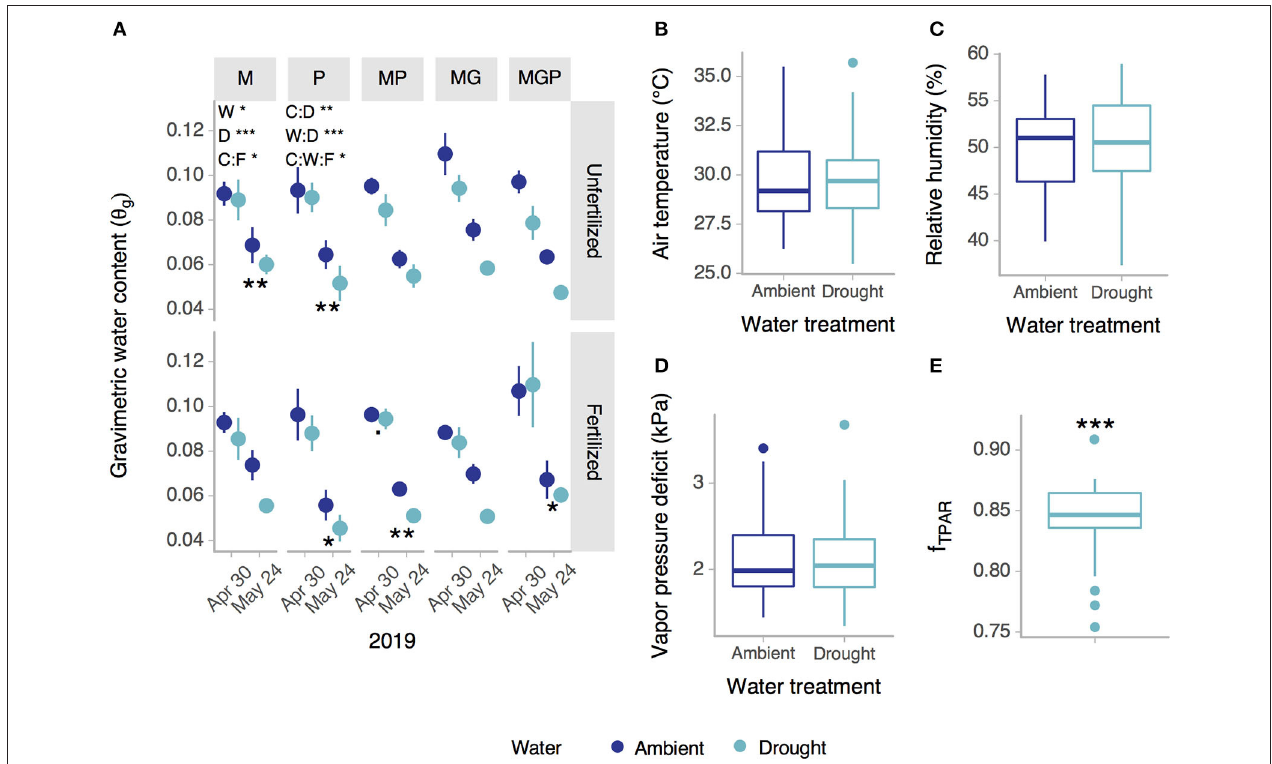
FIGURE 2 | Effects of rainout shelters on (A) gravimetric water content (0–20cm), (B) air temperature, (C) relative humidity, (D) vapor pressure deficit, and (E) the fraction of transmitted photosynthetically active radiation (f TPAR ), (A) within or (B–E) across cropping system-fertilization combinations. Cropping system abbreviations: M, Maize; P, Pigeonpea; MP, Maize-pigeonpea; MG, Maize-gliricidia; MGP, Maize-gliricidia-pigeonpea. Treatment factor abbreviations: W, Water; C, Cropping system; F, Fertilization; D, Date. Asterisks indicate significant differences between ambient and drought (*** p < 0.001, ** p < 0.01, * p < 0.05). Error bars = standard error; (A) n = 3 or (B–E) n =